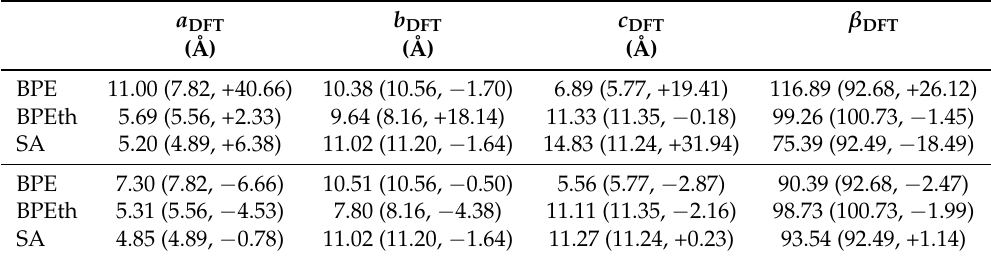
Table 1. Lattice parameters of co-crystal components BPE, BPEth, and SA, using DFT (top) and DFT-D (bottom). All lattice constants are reported in units of Å, and both the experimental value and % deviation from experimentally determined values are given in